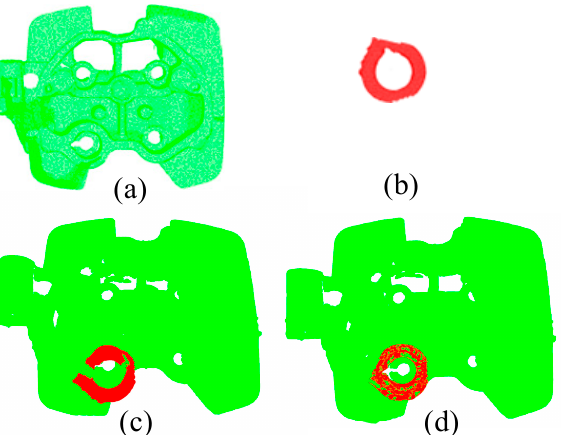
Figure 14. Local feature based matchingMatching of local features. ( a ) Workpiece data template ( b ) Local feature data template ( c ) Coarse alignment positioning ( d ) Fine alignment positioning